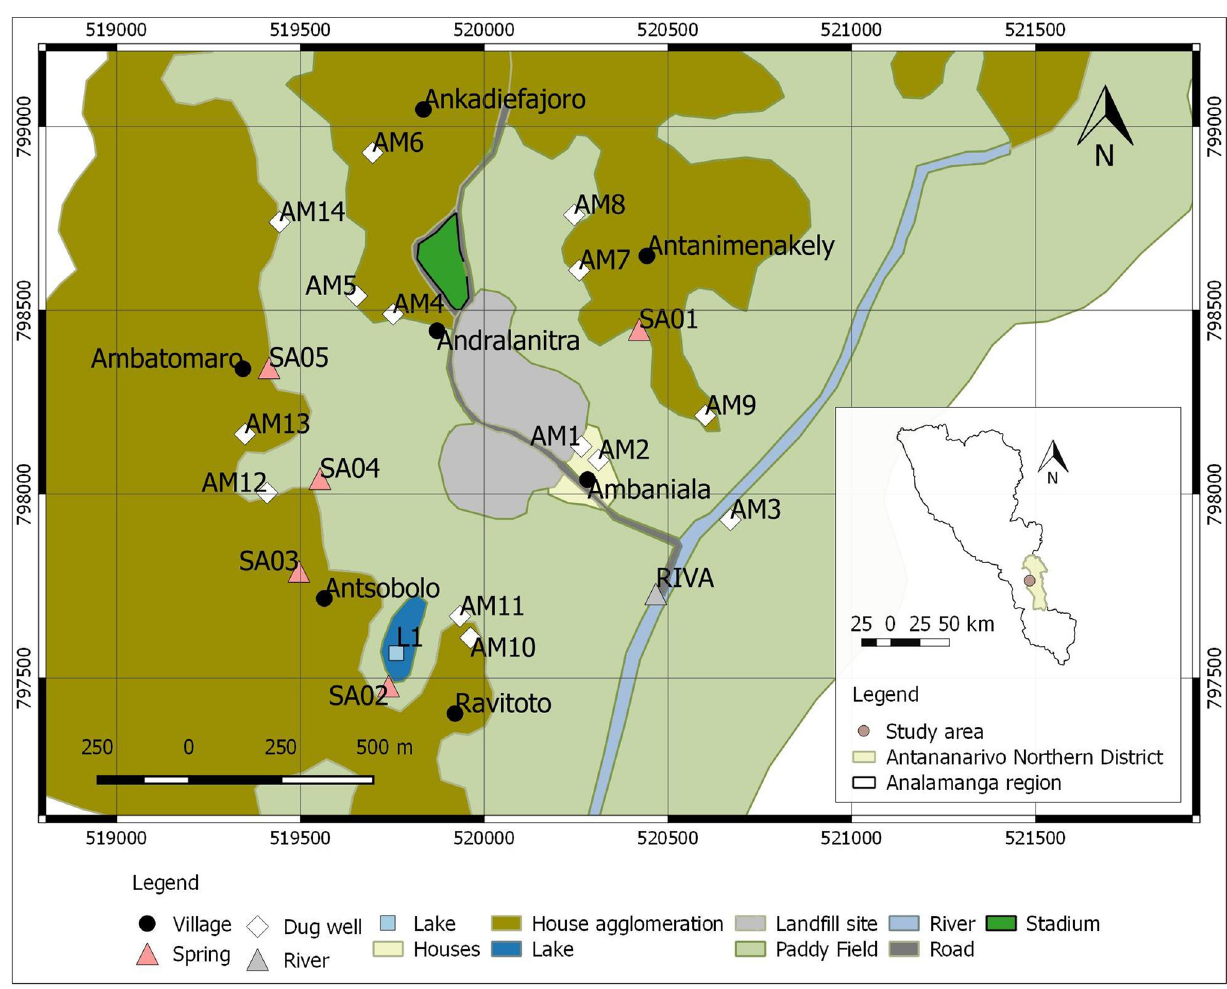
Fig. 1 Study area location, Source Google Earth, georeferenced and digitized using QGIS 2.14